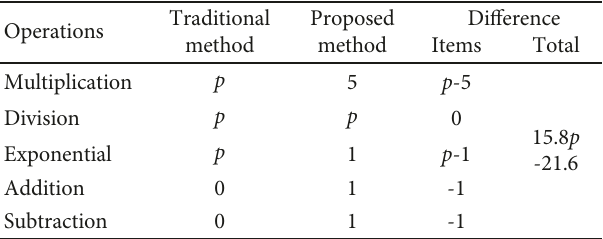
Table 1: The complexity comparison ( p -point Gaussian quadrature).